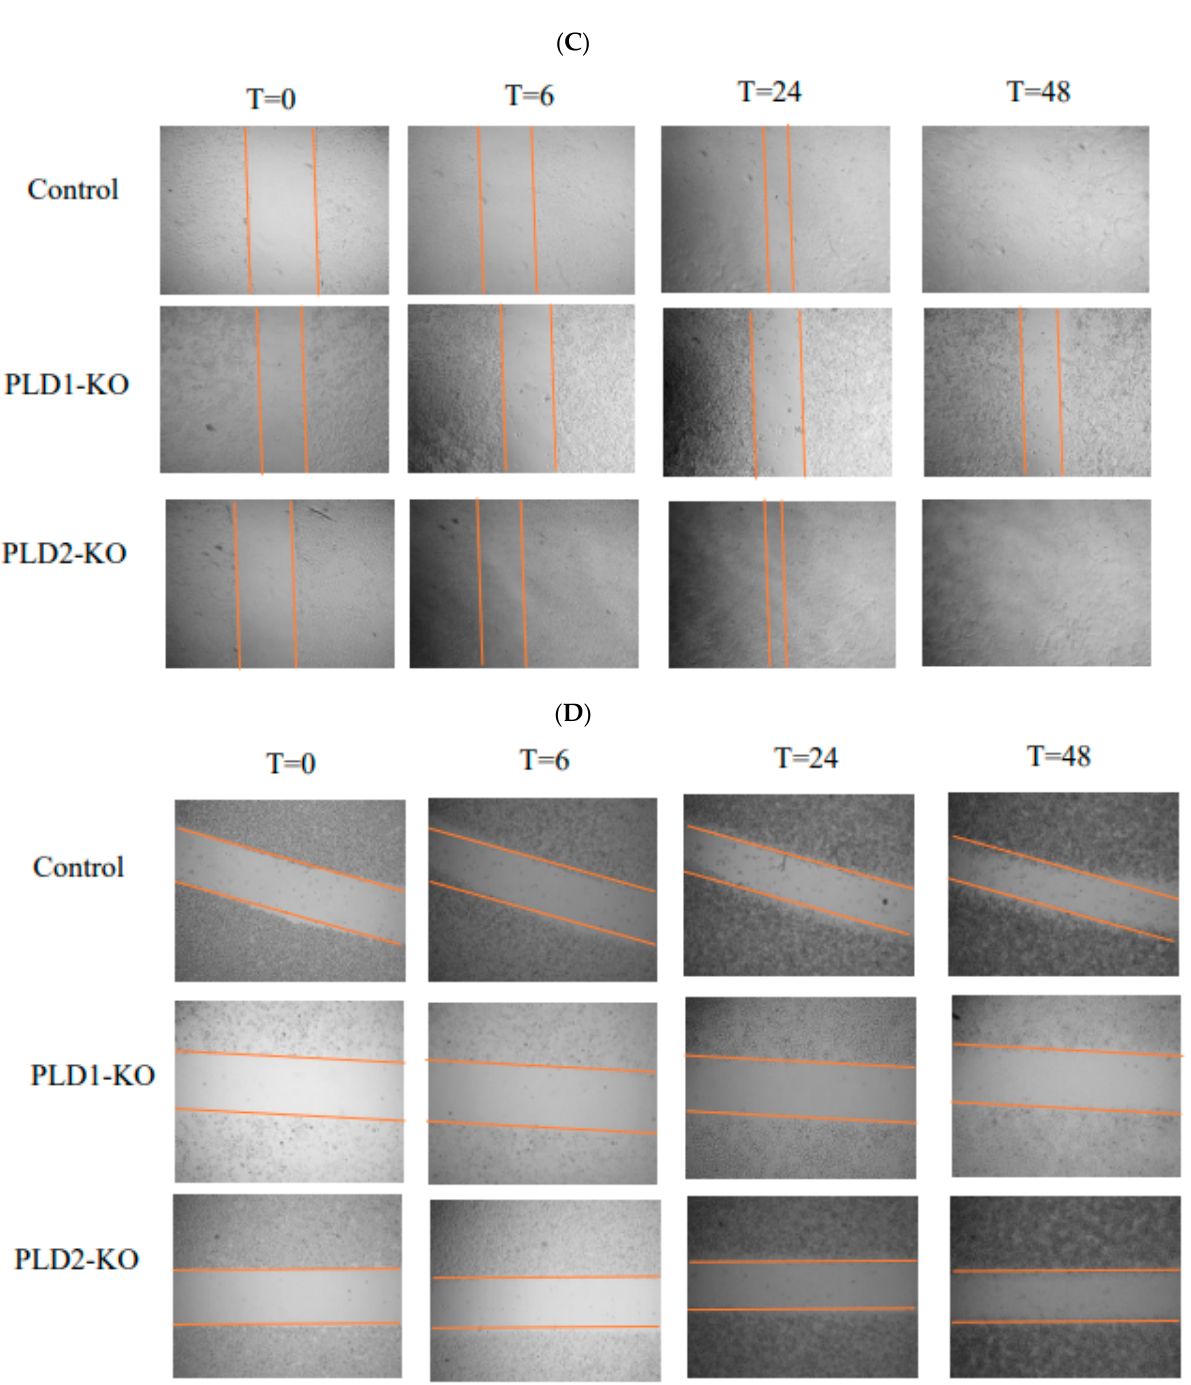
Figure 3. Cell migration (scratch wound healing assay). Wound healing assay in OVCAR3 and OVCAR8 cultured cells. Cells’ monolayers, cultured in 6-well plates, were injured with a sterile 10 µ L pipette tip (original wound). ( A , B ) Graphs showing percentage of wound closure in both cell cultures in control and Knock out cells. PLD1-KO cells reduced motility whereas PLD2-KO cells increased cell motility compared to control cells (group size: n = 12 for each group). Values of percentage wound closure ± SEM; * p < 0.05, **, p < 0.01. Wound healing microscopy is shown to demonstrate cell migration in both cell cultures. ( C ) Representative images from in vitro scratch wound healing assays demonstrating that cell migration into the cell-free region is significantly reduced in PLD1-KO cells and increases in PLD2-KO cells. ( D ) Representative images from in vitro scratch wound healing assays demonstrating that cell migration into the cell-free region is significantly reduced in PLD1-KO cells and increases in PLD2-KO